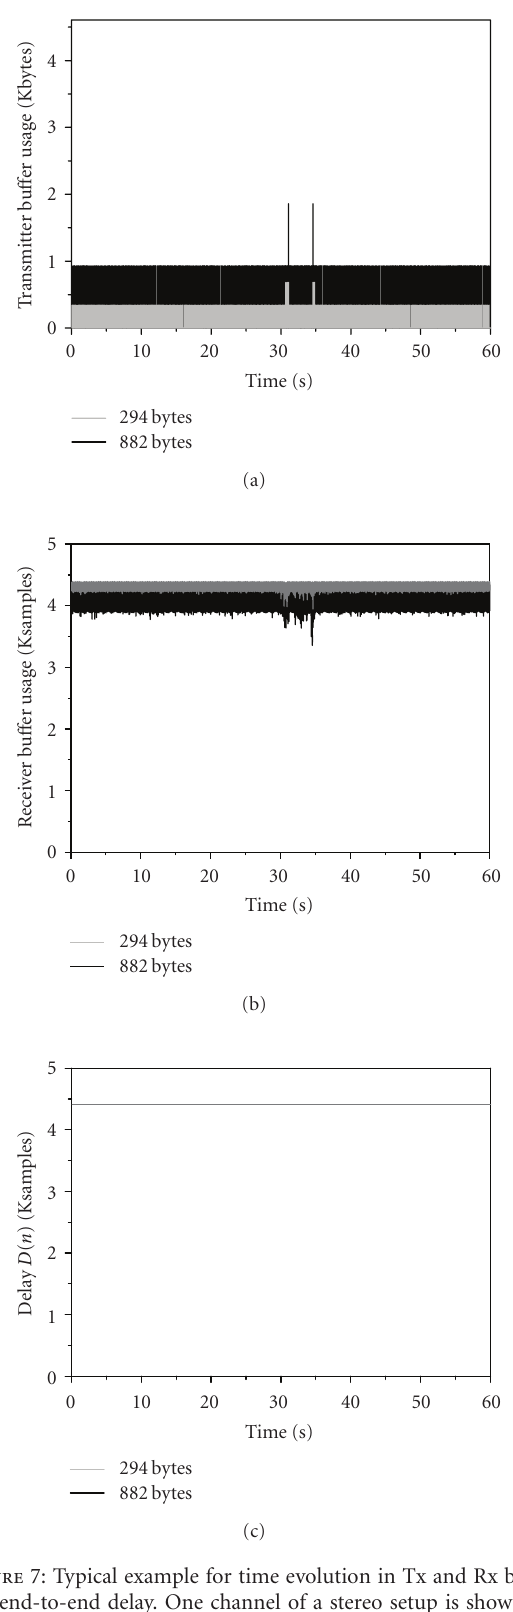
Figure 7: Typical example for time evolution in Tx and Rx bu ff er and end-to-end delay. One channel of a stereo setup is shown for di ff erent packet sizes (SETT-EDD scheduler and medium interfer- ence): (a) Tx bu ff er usage, (b) Rx bu ff er usage, (c) delay D ( n ) with- out and with CoDeS synchronization (identical